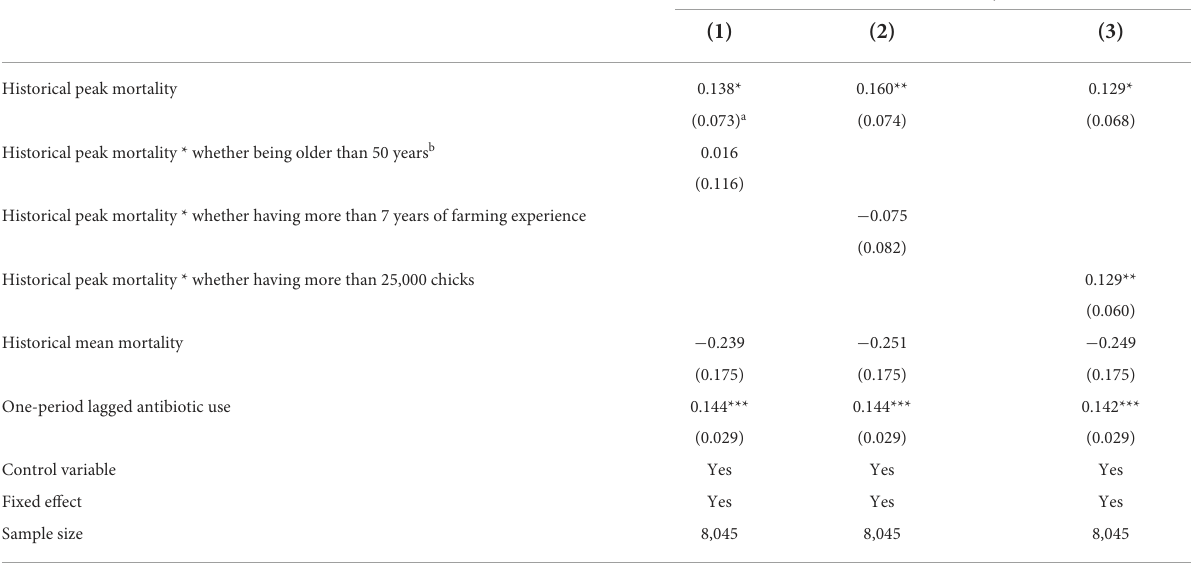
TABLE 5 Different effects of historical peak mortality on different categories of